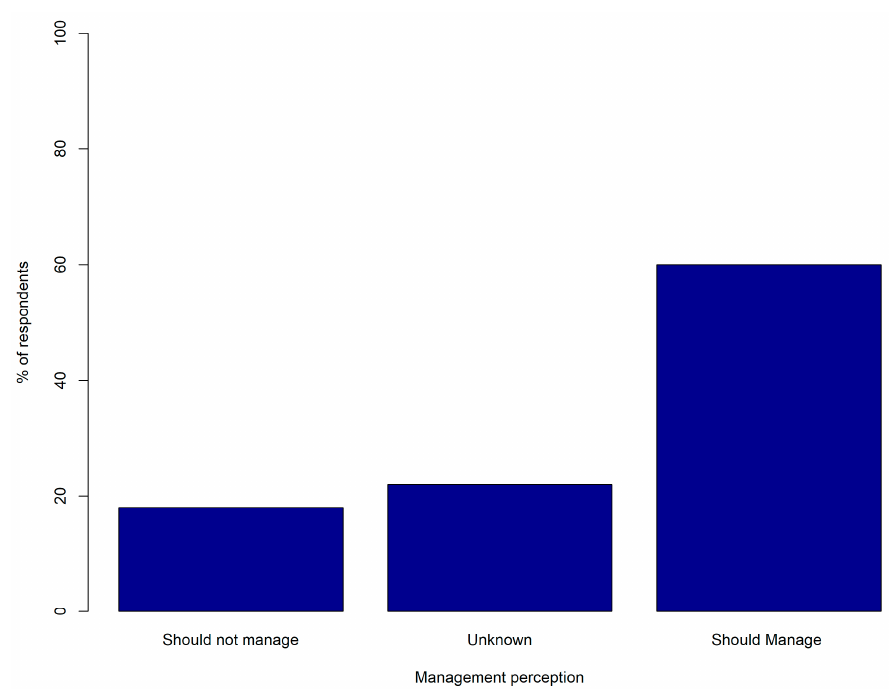
Figure 4. Perception of whether management of aquatic plants should be implemented in Lake Léman.